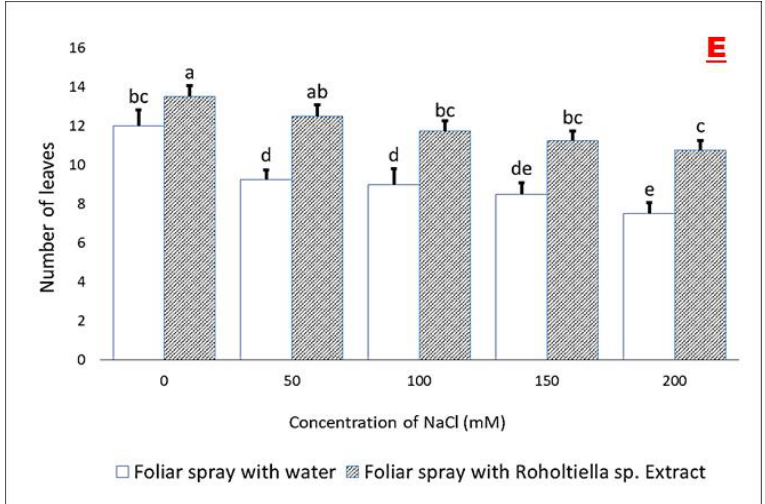
Figure 1. Effect of Roholtiella sp. extract on the shoot height ( A ), root length ( B ), fresh weight ( C ), dry weight ( D ), and ( E ) the number of leaves in salt-stressed bell pepper seedlings. The different letters (a–g) indicate significantly different values in response to the different treatments.